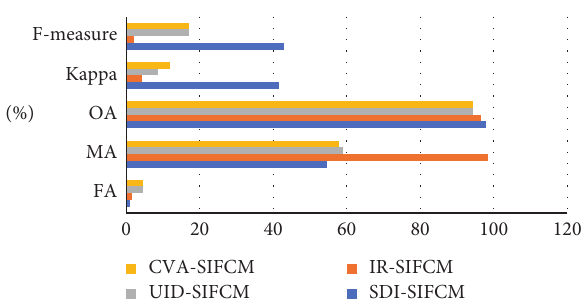
Figure 5: Bar graph of the first group of comparative experimental results of the second group of